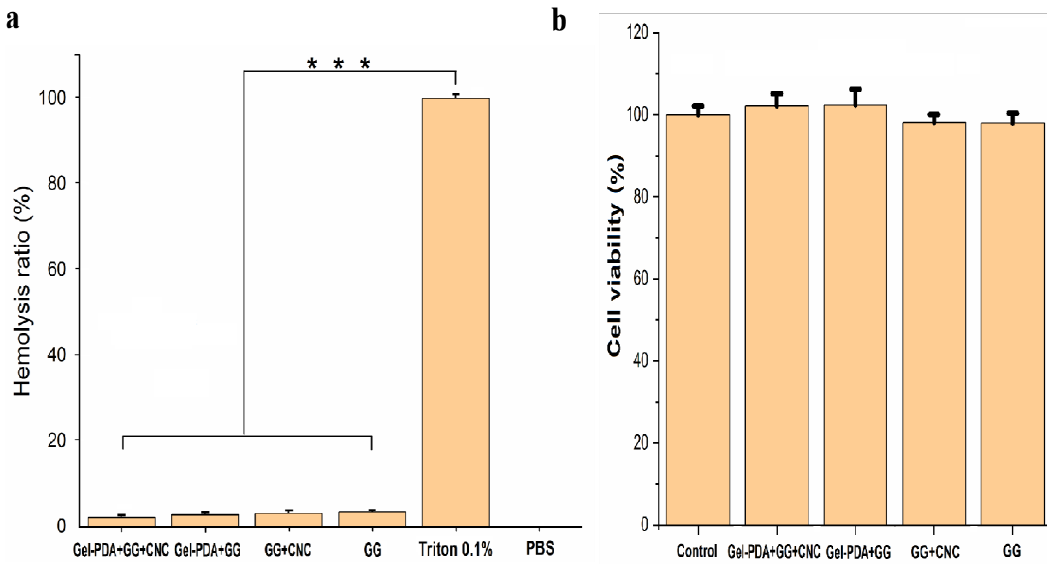
Figure 7. Hemocompatbility and cytocompatability of hydrogels. ( a ) The effect of hydrogels on the hemolysis ratio (*** p < 0.001), ( b ) cell viability of HepG2 cells incubated with hydrogels for 48 h.